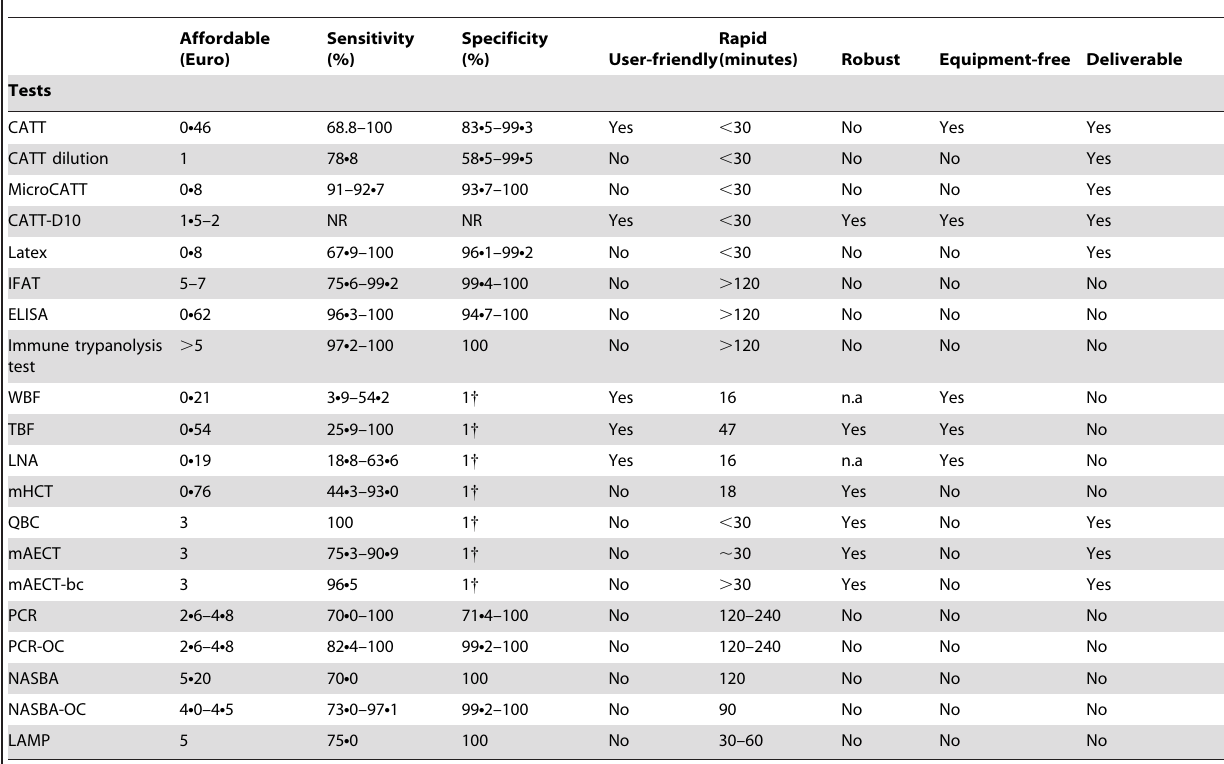
Table 1. Evaluation of feasibility of all methods according to ASSURED